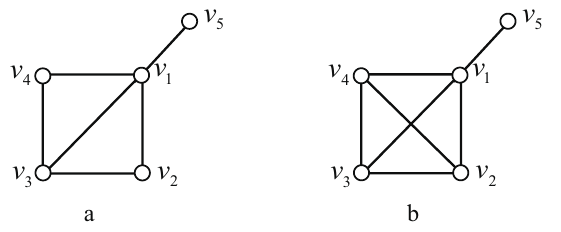
Figure 5. Vertex v 5 is exactly adjacent to one vertex of C 4 . For a , v 2 and v 4 are nonadjacent; for b , v 2 and v 4 are adjacent.